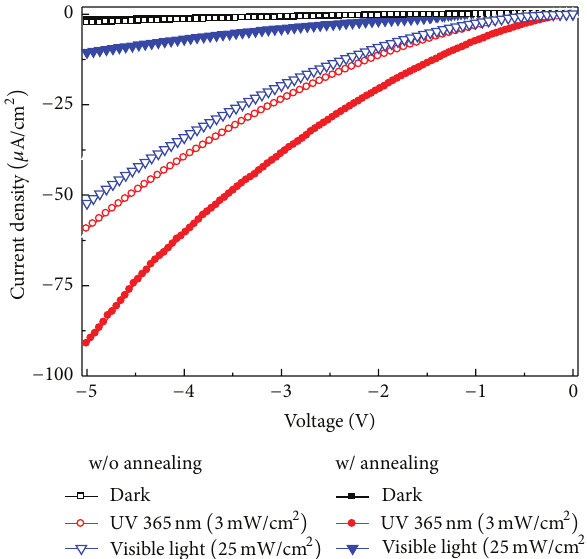
Figure4:Comparisonsofexperimental 𝐽 - 𝑉 curvesofp-Cu 2 O/ZnO (HTG) sample with and without thermal